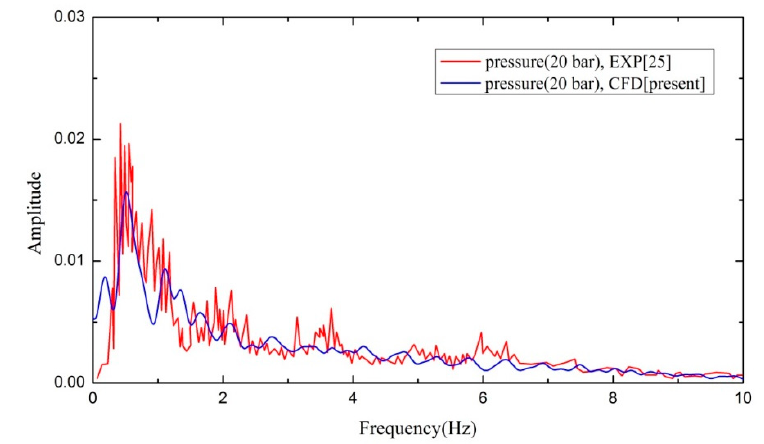
Figure 4. Comparison of the marginal spectrums between experiment and CFD (computational fluid dynamics) data.